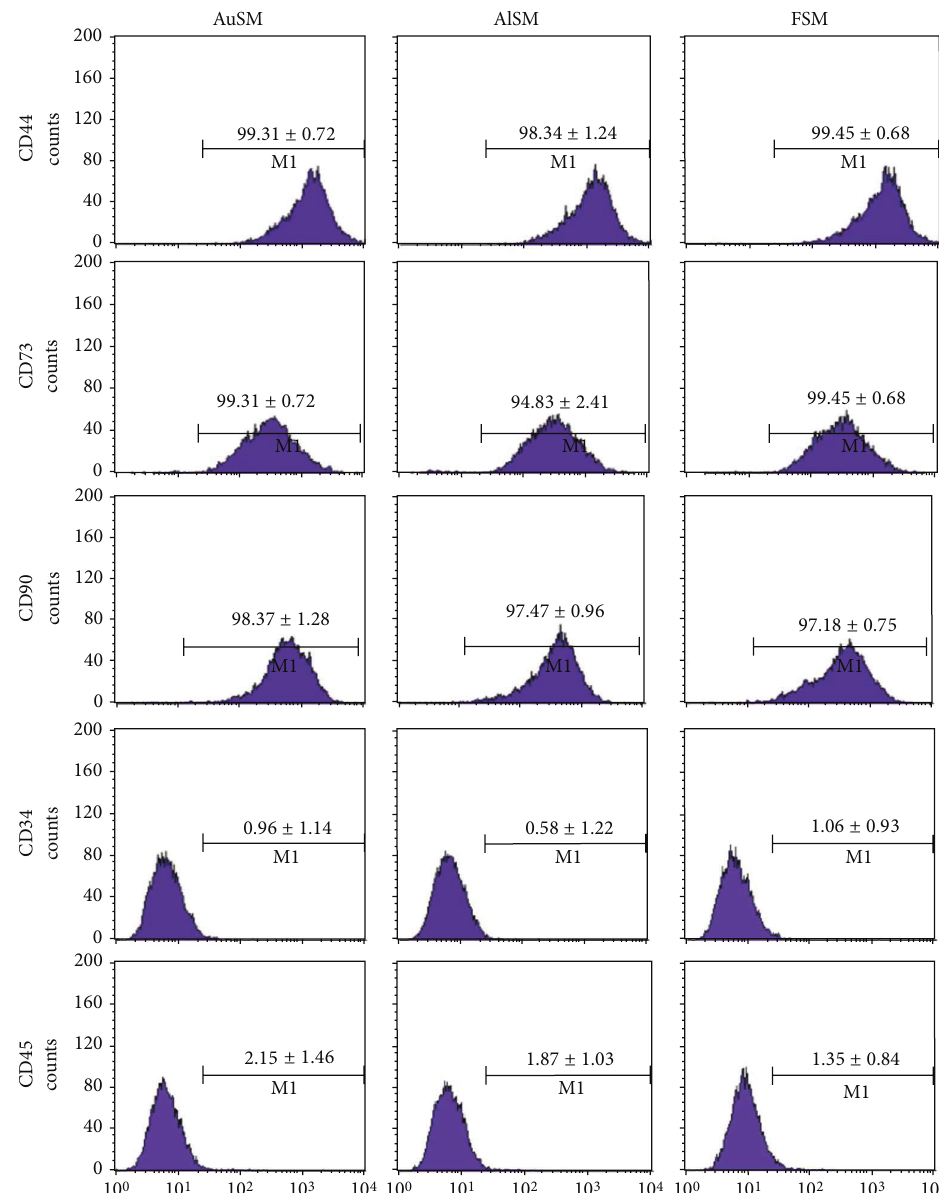
Figure 5: Flow cytometry analyses of surface markers expressed in BMSCs. BMSCs cultured in AuSM, AlSM, and FSM were positive for CD90, CD73, and CD44 but negative for CD31 and CD45 ( 𝑛 = 3 ). The expression of surface markers did not depend on culture